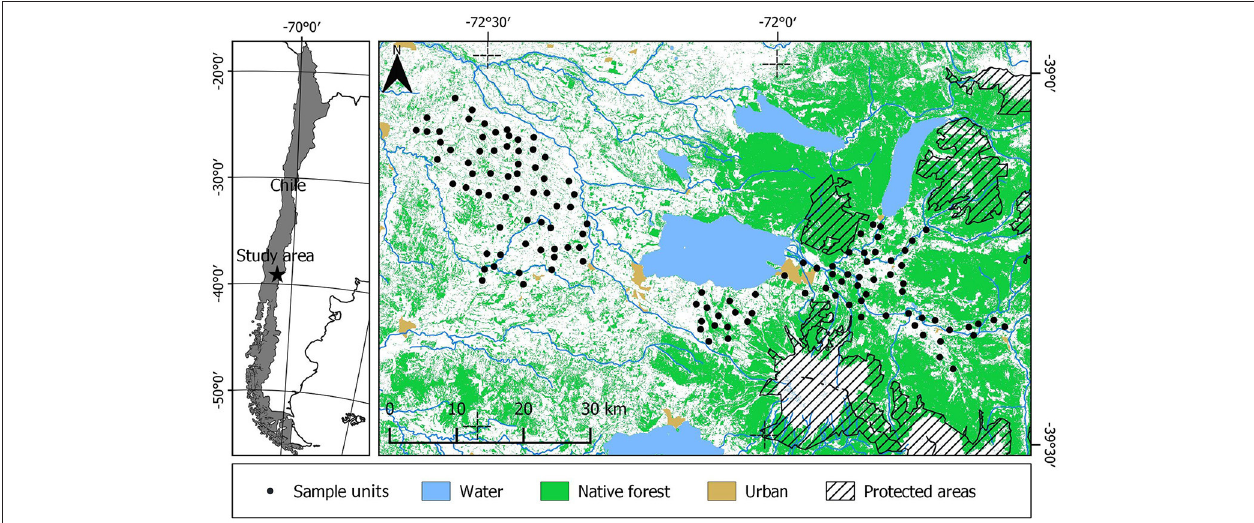
FIGURE 1 | Survey area in La Araucanía region of southern Chile. One or two households were surveyed within each of the 145 sample units (4 km 2 ) distributed across the study region. White background is mainly agricultural land use. Major water bodies correspond to Villarrica, Caburgua and Colico lakes. Protected areas are shown at high elevation sites within the Andes mountain